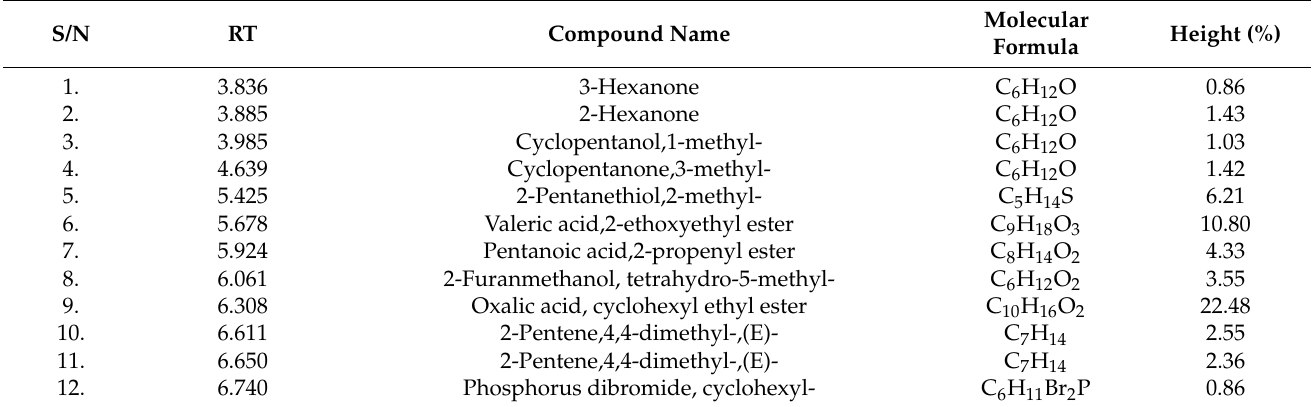
Table 7. Compounds found in the hexane extracts of D. villosa leaves by GC–MS